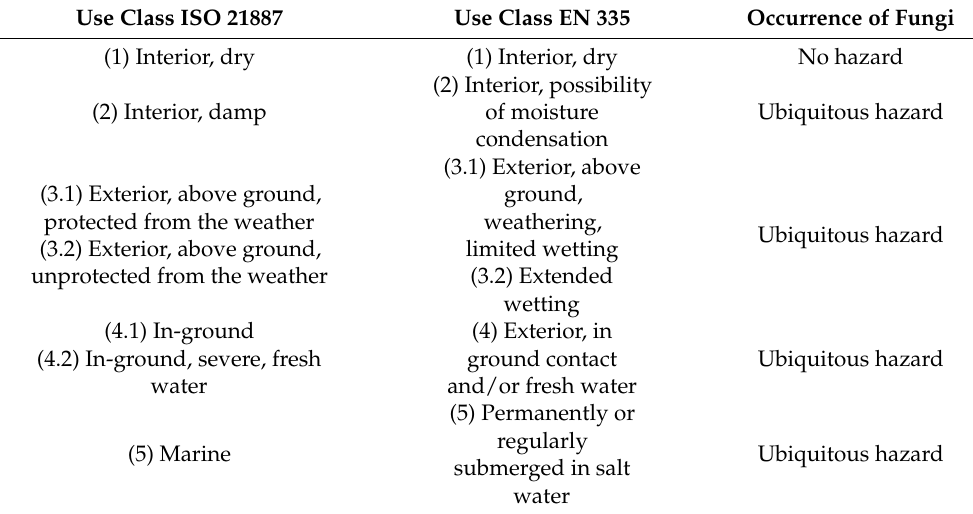
Table 1. A simplified version of the ISO 21887 [15] and EN 335 [14] use classification of wood and the risk of fungal